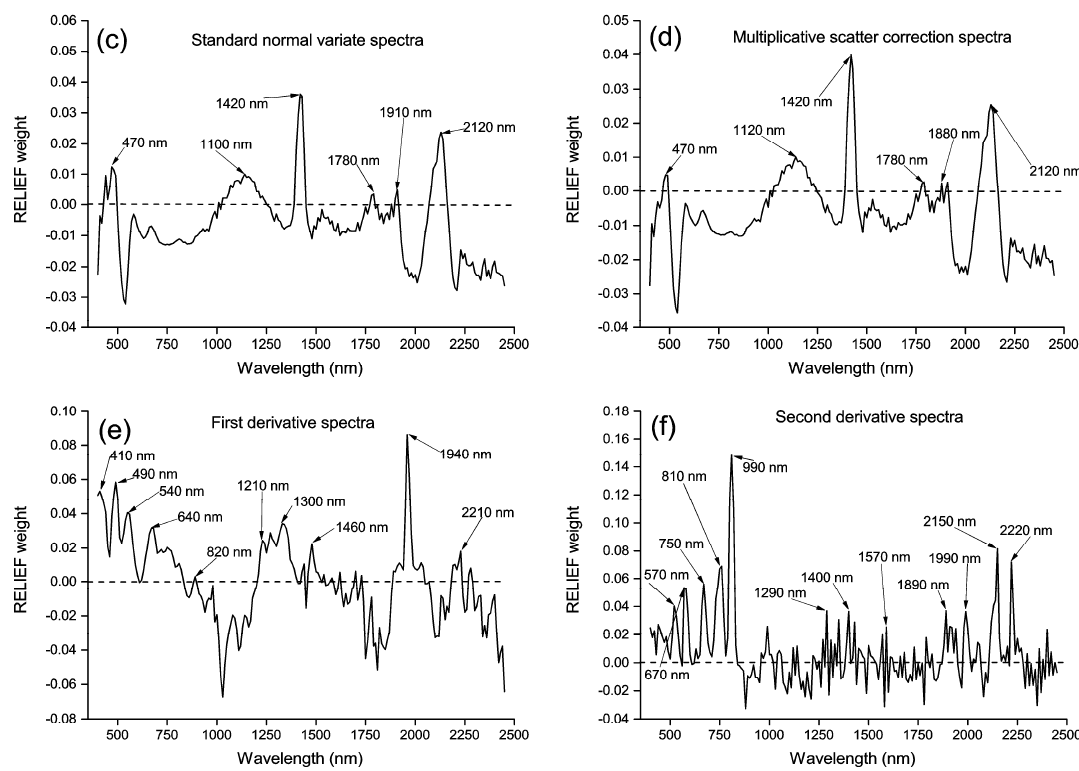
Figure 3. RELIEF weights and the selected spectral features for original reflectance spectra ( a ), mean centering spectra ( b ), standard normal variate spectra ( c ), multiplicative scatter correction spectra ( d ), first derivative spectra ( e ), and second derivative spectra ( f ). The threshold of RELIEF weight was set to 0 (horizontal dashed lines).